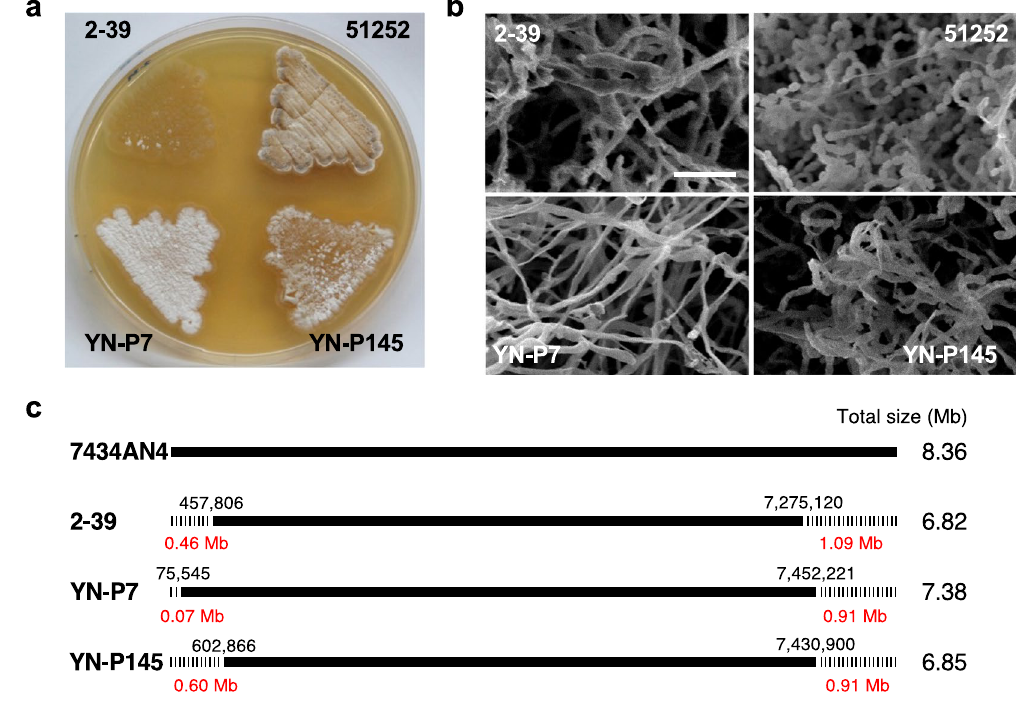
Figure 5. Morphological differentiation of three plasmidless mutants of S. rochei and their chromosomal deletion. ( a ) Spore formation of S. rochei strains. Strains (2-39, YN-P7, YN-P145, and their parent 51252) were grown on YM agar medium at 28 °C for 5 days. ( b ) Scanning electron microscopy (SEM) of surface grown colonies. ( c ) Chromosomal deletions in mutants 2-39, YN-P7, and